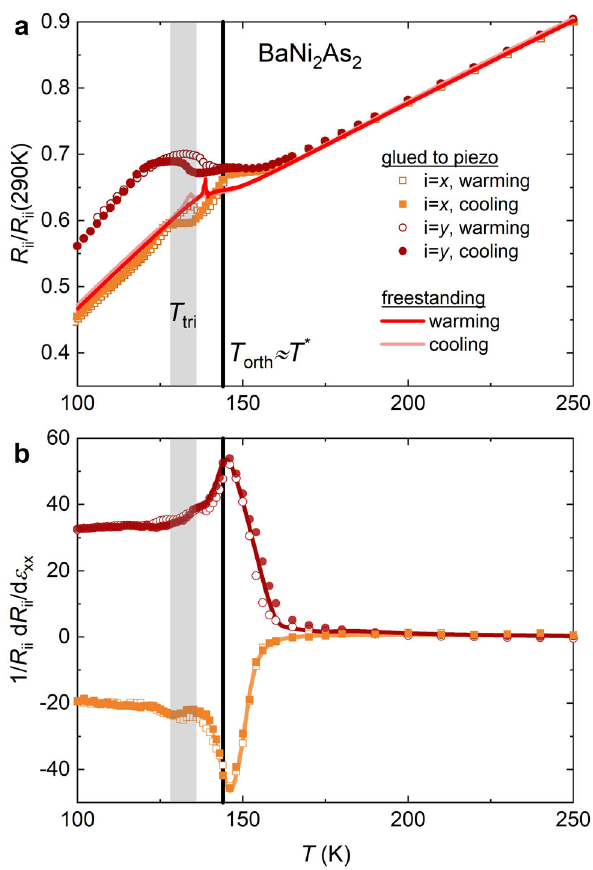
Fig. 2 Elastoresistance measurement of BaNi 2 As 2 . a Normalized electrical resistances recorded with the sample [100] tet axis glued along the poling direction of the piezo. Longitudinal ( i = x , orange squares) and transverse measurements ( i = y , dark red circles) correspond to resistances measured along and perpendicular to the piezo poling axis, respectively. No voltage is applied to the piezo. For comparison the freestanding resistance from Fig. 1a is added (dark and light red lines for warming and cooling measurements, respectively). b Corresponding slopes of the normal- ized resistance versus strain variation, 1/ R ii ( dR ii / d ϵ xx ), obtained through sweeping the piezo voltage at fi xed temperatures. The fi lled (respectively empty) symbols correspond to cooling (resp. warming) measurements. The gray shaded area shows the temperature range of the triclinic structural transition upon cooling, while the vertical line denotes T orth , i.e., the orthorhombic transition temperature as determined by thermal expansion 26,32 . The tem- perature of the maximum of the elastoresistance, T * , is consistent with T orth . Lines are guide to the discrepancy appears below T ≈ 145 K, that corresponds to the second-order orthorhombic transition temperature, T orth , as determined by thermal expansion measurements 26,32 . This obser- vation evidences that, within the orthorhombic state, the sample is, at least partially, detwinned through the anisotropic thermal expansion of the piezo (see Supplementary Note 2) and the resulting strain. The normalized freestanding resistance (dark and light red lines for the warming and cooling measurement, respectively), repro- duced from Fig. 1a, also overlaps with that of the sample glued to the piezo down to ≈ 160 K. However, at lower temperatures, a difference appears which can be attributed to the differential thermal expansion of the piezo and BaNi 2 As 2 together with the